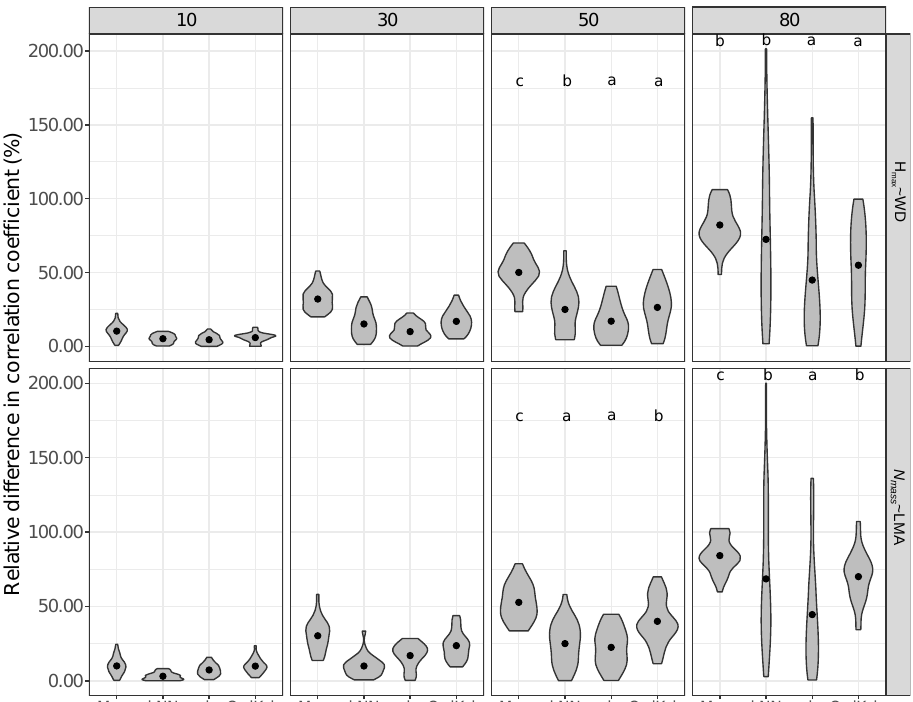
Figure 3. Errors in the correlation coefficient for two selected trait relationships at increasing missingness levels (10–80%) and for different imputation methods: overall trait mean (Mean), mice (using only the trait matrix in the predictor set), kNN (using only the trait matrix for the distance calculation) and ordinary kriging (OrdKrig). Letters denote results of multiple comparisons, in alphabetical order from highest to lowest performance. Traits involved in the relationships are leaf nitrogen per unit mass, N mass (%mass); maximum tree height, H max (m); leaf mass per area, LMA (mgcm − 2 ); wood density, WD (gmcm − 3